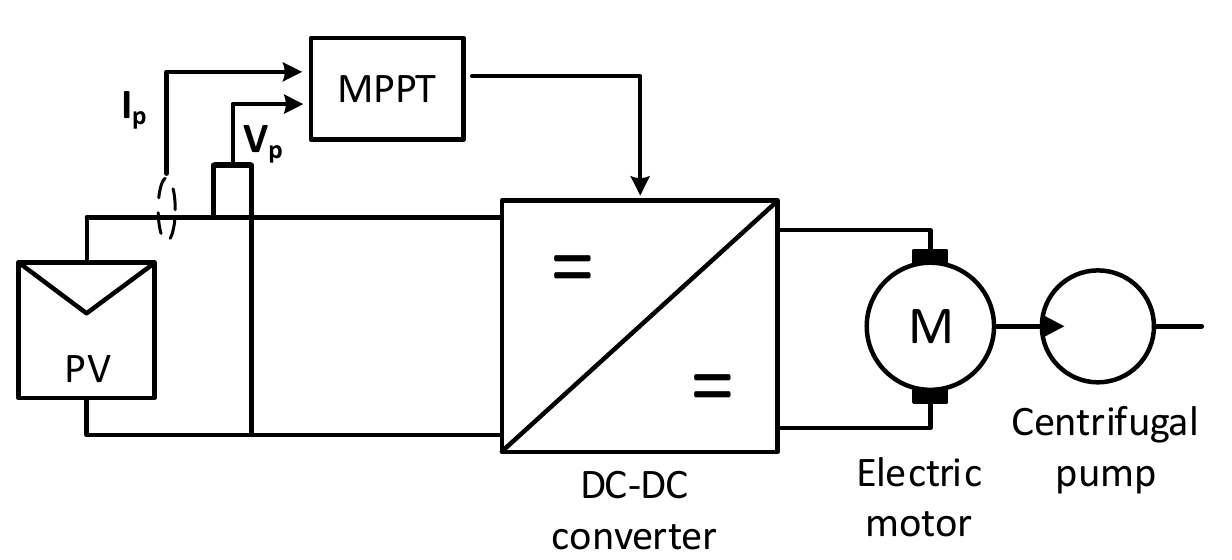
Figure 6. The general block diagram of SWPP with MPPT controller.